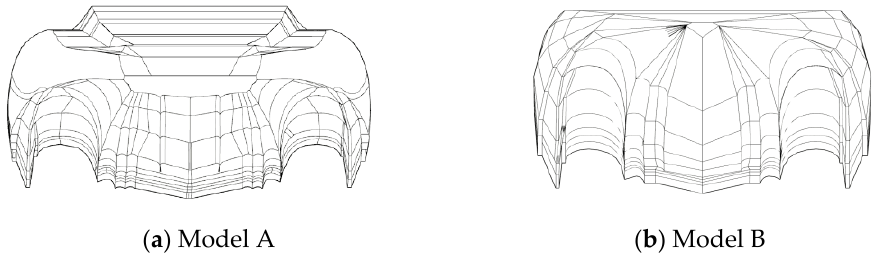
Figure 3. Body plans of the studied planing trimaran hulls [12,42]. Table 2. Principal characteristics of the studied models [12,42].